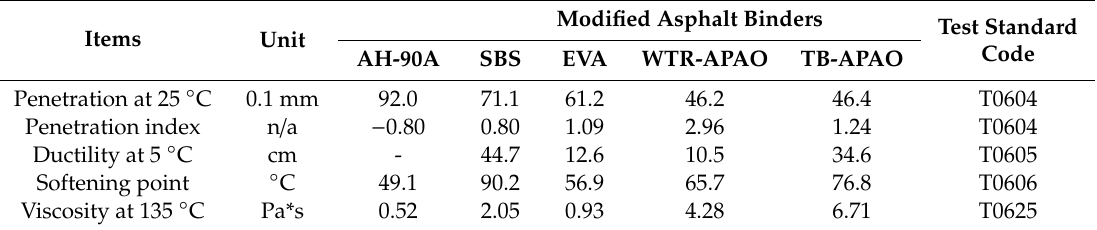
Table 1. Main Technical Index of Used Four Kinds of Asphalt (According to the Chinese standard of JTG E20-2011